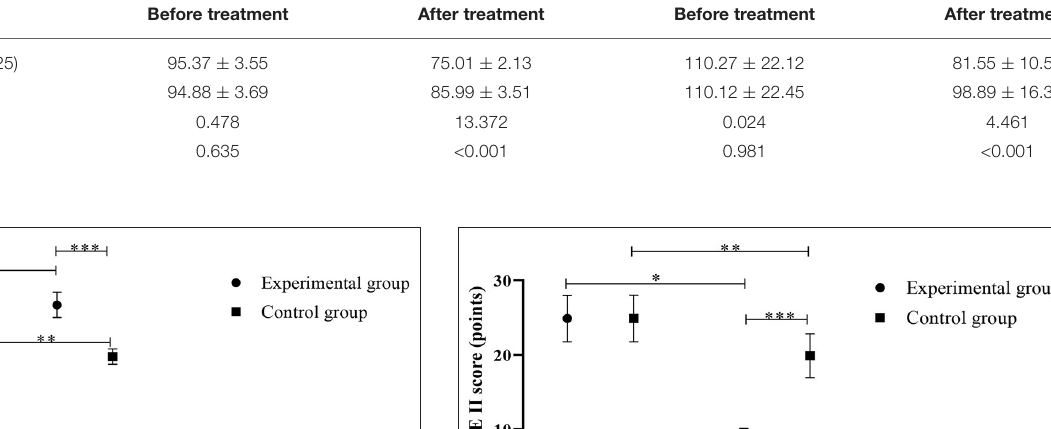
TABLE 3 | Comparison of hemodynamic indexes between the two groups (mean, SD). Groups